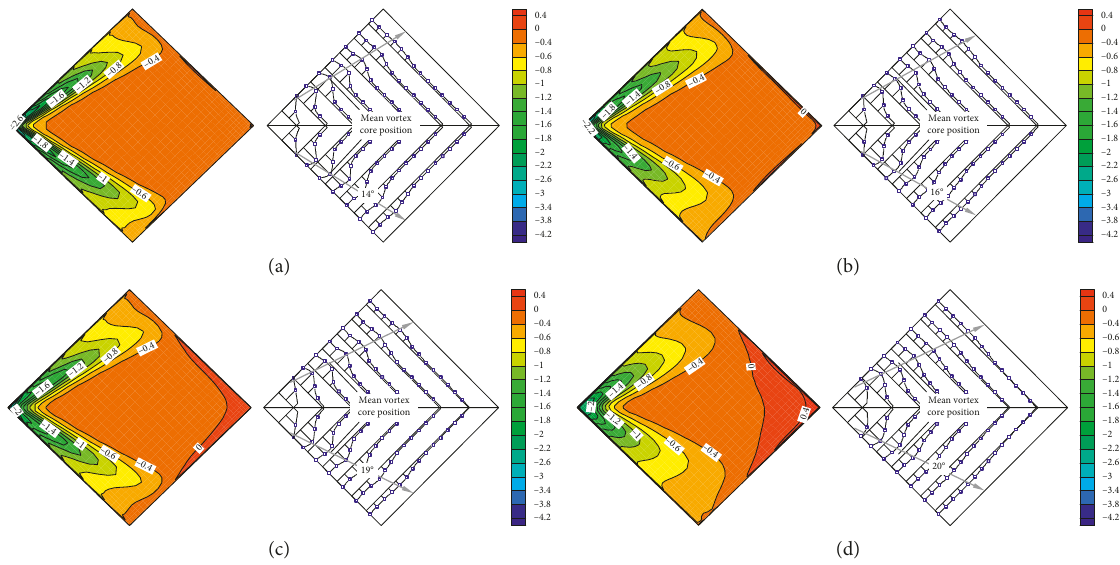
Figure 11: Contours of mean pressure coefficients and mean suction profiles on flat roofs with optimal parapet porosities, for different relative parapet height cases. (a) h p / H ( ϕ 15.5%). (cid:30)